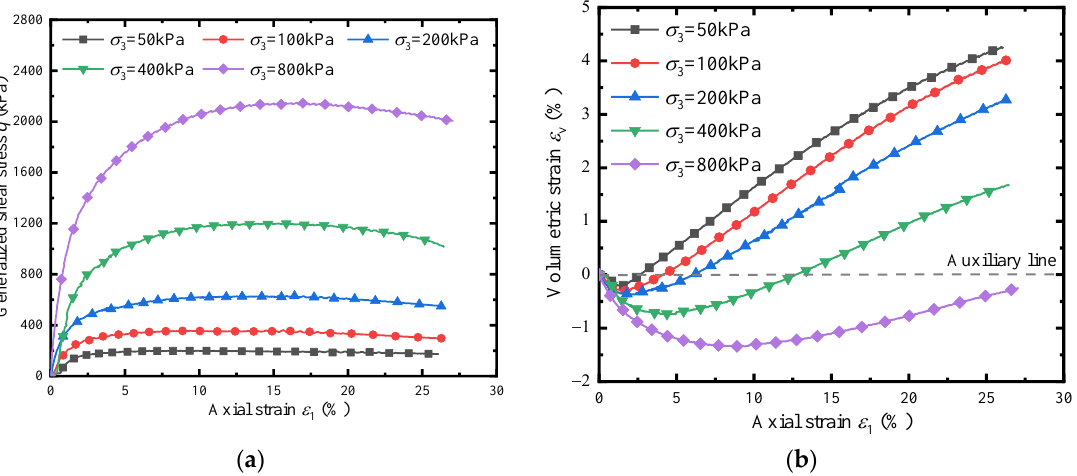
Figure 4. Relationships between stress and volumetric strain with axial strain at drained condition. ( a ) Stress-strain relationships. ( b ) Volumetric strain-strain relationships. Figure 5a,b show the variation of generalized shear stress and pore pressure with axial strain under undrained conditions. Figure 5a shows that the stress-strain relationships are softened only at relatively low effective confining pressures (e.g., 50, 100 and 200 kPa), and hardened at high ef- fective confining pressures (>200 kPa). A greater effective confining pressure gives rise to a greater elastic modulus and a higher peak strength. Compared with the stress-strain relationships under the drained condition, the peak stress point of the undrained test is higher and the elastic-plastic stage is longer under the same load conditions. The results suggest that the undrained shear rate needs to be reduced to fully dissipate the excess pore pressure. Figure 5b shows the variation of